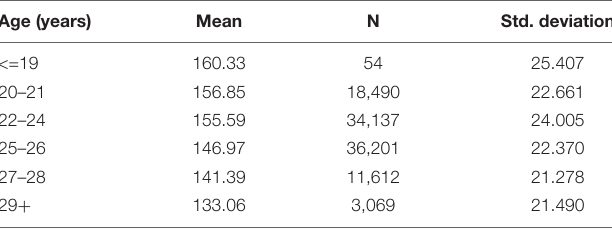
TABLE 2 | Age range and SPRO average.